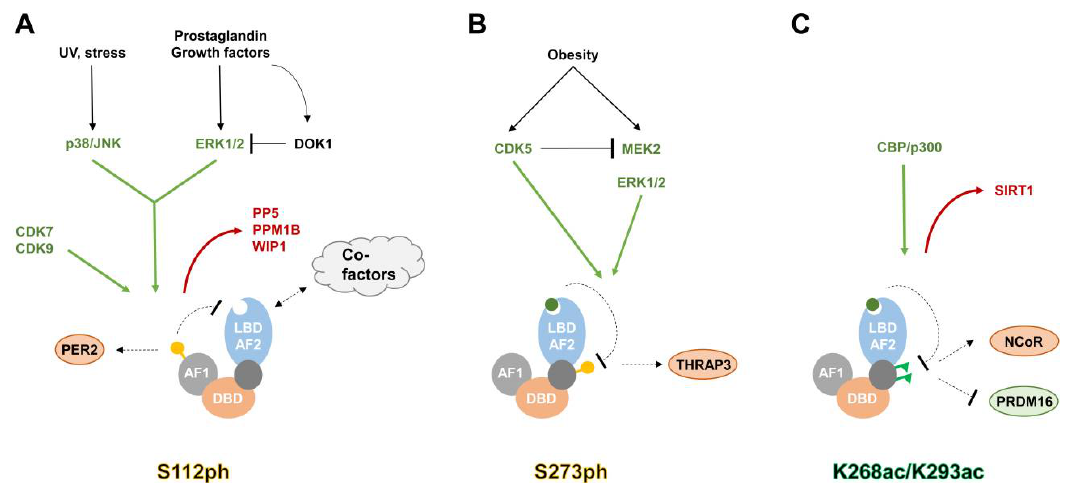
Figure 3. Regulatory mechanisms of selected modifications in PPARγ. ( A ) Activation of the MAPK pathway leads to the phosphorylation of serine 112 by p38/JNK or ERK1/2. S112ph decreases PPARγ activity, either through reducing its ligand binding affinity and co-activator binding, or by increasing Period circadian regulator 2 (PER2) binding, which leads to decreased recruitment to target genes. The adapter molecule Docking protein 1 (DOK1) modulates S112ph levels in response to nutritional inputs. S112ph is also targeted by CDK7 and CDK9. Phosphatases removing S112 phosphorylation from PPARγ are: Protein phosphatase 5 (PP5), Protein phosphatase Mg 2+/ Mn 2+ dependent 1B (PPM1B), and Wild-type p53-induced phosphatase 1 (WIP1). ( B ) Obesity-induced MAPK signaling leads to serine 273 phosphorylation, which enhances binding of the Thyroid hormone receptor associated protein 3 (THRAP3), and repression of certain PPARγ target genes. Phosphorylation levels are modulated by CDK5, either directly by CDK5-medatied S273 phosphorylation, or indirectly via phosphorylation of Dual specificity mitogen-activated protein kinase kinase 2 (MEK2) and suppression of MAPK signaling. Compounds with or without PPAR agonist activity can be used to block S273ph. ( C ) Acetylation of lysines 268 and 293 has been shown to increase NCoR co-repressor binding, whereas NAD (Nicotinamide adenine dinucleotide)-dependent deacetylase sirtuin-1 (SIRT1)-mediated deacetylation of K293 favours PR domain containing 16 (PRDM16) binding and expression of thermogenic genes. Ligand binding enhances SIRT1-PPARγ interaction and K268/K293 deacetylation. AF1: activation function 1 domain; DBD: DNA-binding domain; LBD-AF2: ligand binding and activation function 2 domain; enzymes depositing PTMs are colored in green, enzymes removing PTMs are shown in red; green circle: PPARγ-ligand; yellow circle: phosphorylated serine; green triangle: acetylated lysine; black arrow: activation; green arrow: PTM deposition; red arrow: PTM removal; black T symbol: inhibition; dotted arrow: increased interaction/stimulation; dotted T symbol: decreased interaction/inhibition.